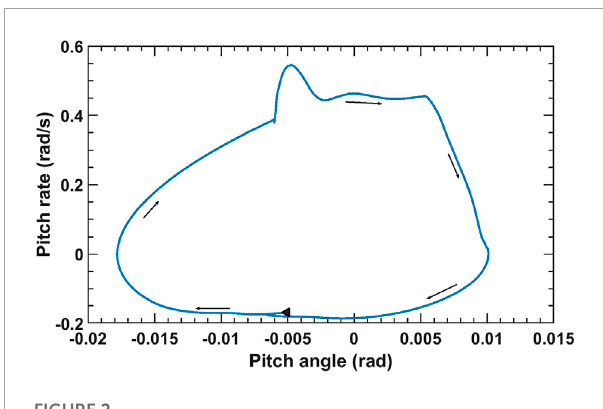
FIGURE 2 Plot of pitch rate vs. pitch angle for r = 14 ° , P td = 3 × 10 5 Pa and angular velocity ω = 90 deg/s. The black triangle displays the beginning of the